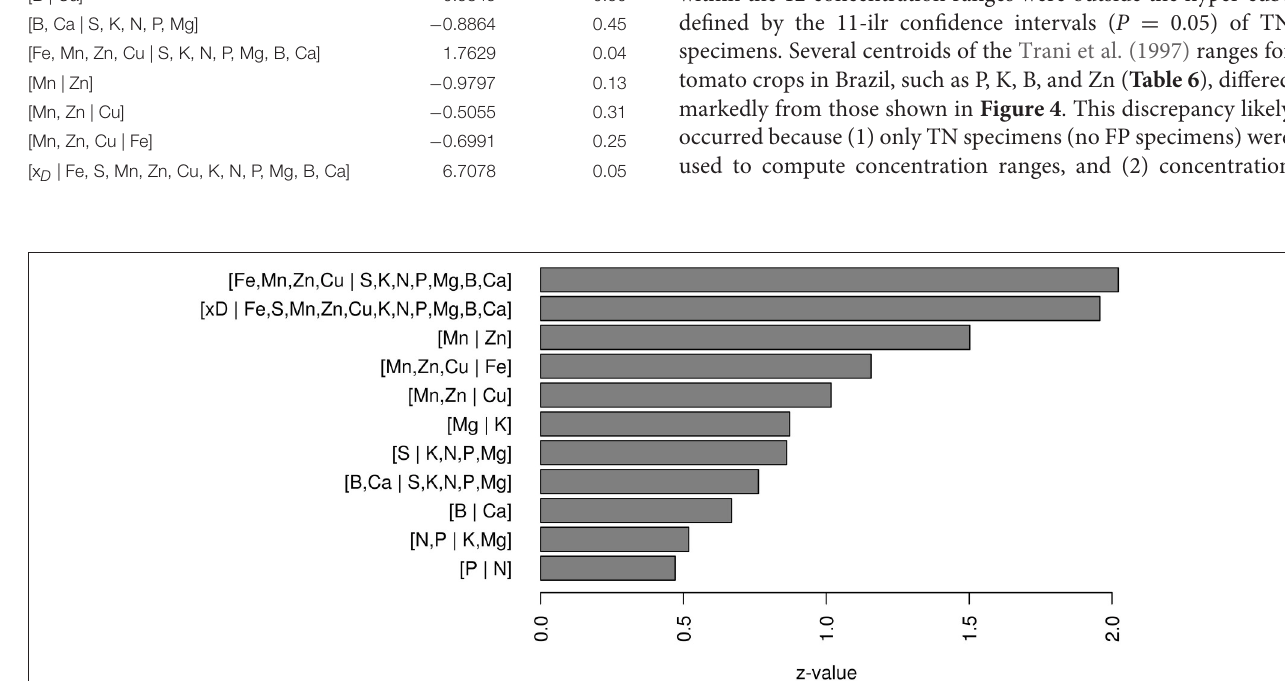
Frontiers in Plant Science |